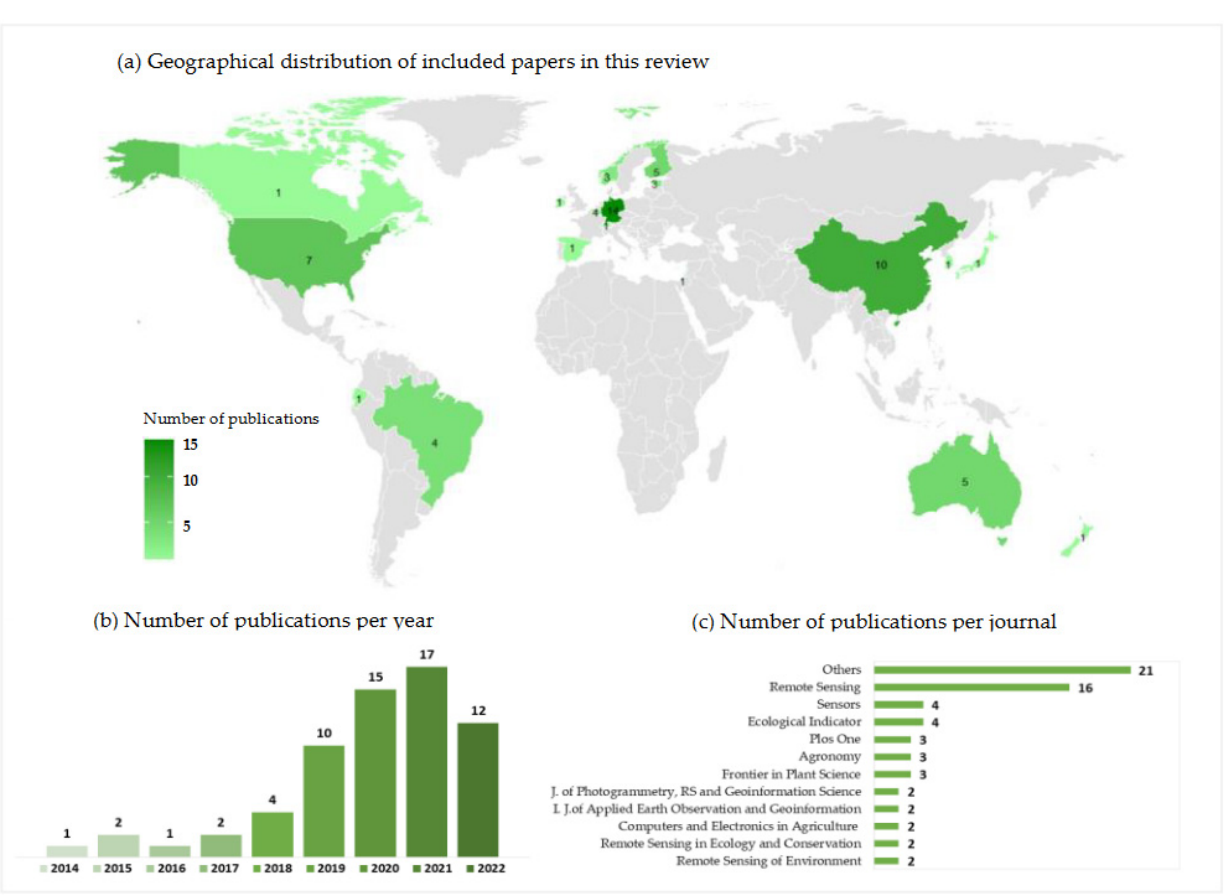
Figure 2. ( a ) Geographical distribution of included papers in this review. ( b ) Number of publications per year. ( c ) Number of publications per journal.